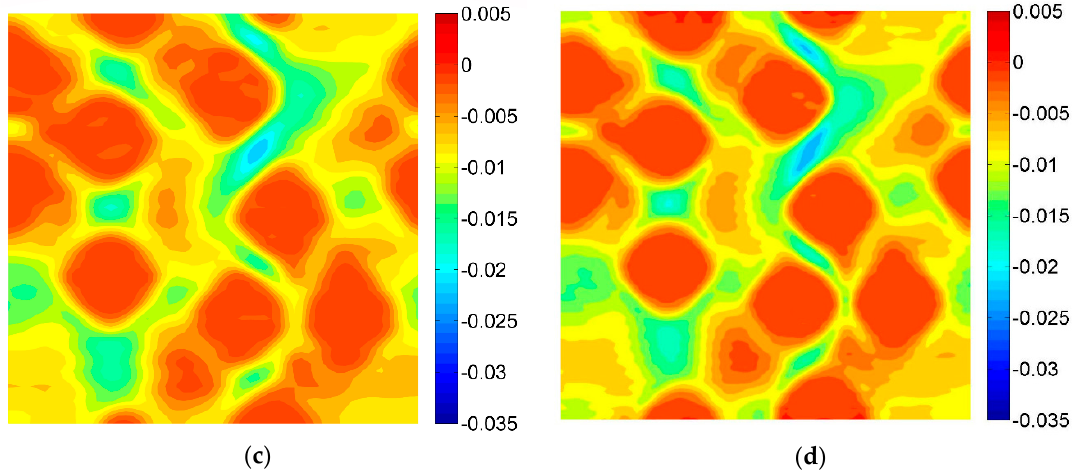
Figure 14. Distribution of strain ε 22 obtained for Material 2 with consideration of different speckle sizes, grid of squares: ( a ) 50 × 50, ( b ) 100 × 100, ( c ) 150 × 150, ( d ) 200 × 200.